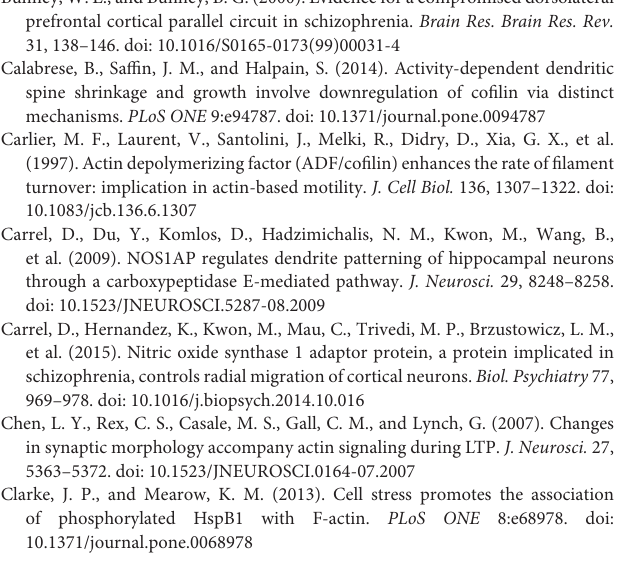
Supplementary Figure 1 | Western Blot analysis of GFP expression. Extracts from cultures of COS-7 cells expressing GFP (control), NOS1AP-L, or NOS1AP-S were resolved by SDS-PAGE and analyzed by Western blotting using an antibody that recognizes GFP. Representative blot is shown. Black asterisks denote GFP fusion proteins. Amersham ECL Rainbow Molecular Weight Markers (GE Healthcare Life Sciences) and PageRuler TM Plus (Thermofisher Scientific) ladders were